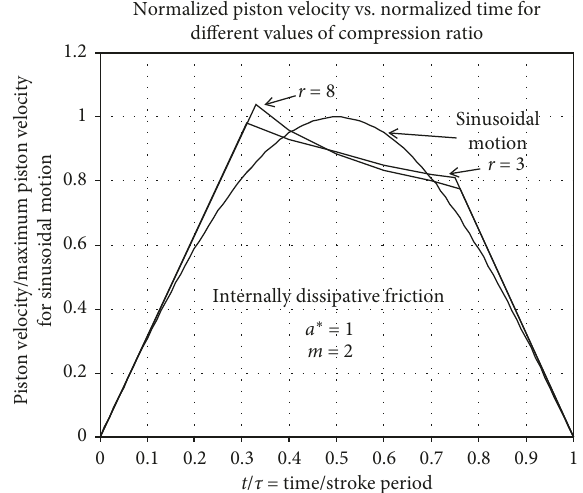
Figure 8: Example of sensitivity of optimal piston motion to compression ratio r , for internally dissipative friction. Maximum nondimensional piston parameter a ∗ � 1. Frictional exponent m � 2. Plots are for (1) conventional motion; (2) optimal motion with r � 3; (3) optimal motion with r � 8. The abscissa is time divided by stroke time ( t / τ ), and the ordinate is piston velocity relative to its maximum value for the conventional trajectory.